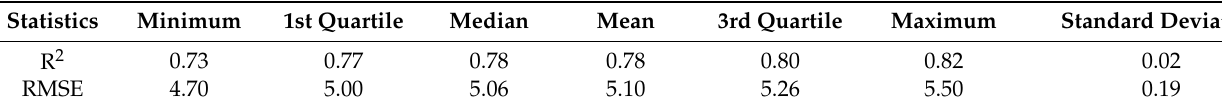
Table 2. Evaluation of the performance of random forest model in predicting SOC stock.